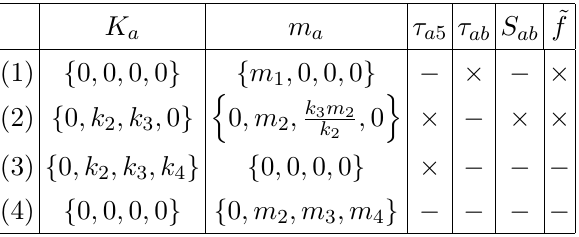
Table 1 . Solutions for g = ( II )+ u (1) in which (cid:2) indicates a non-zero embedding tensor component. Of these note that (cid:21) a is non-zero only for the (cid:12)rst two